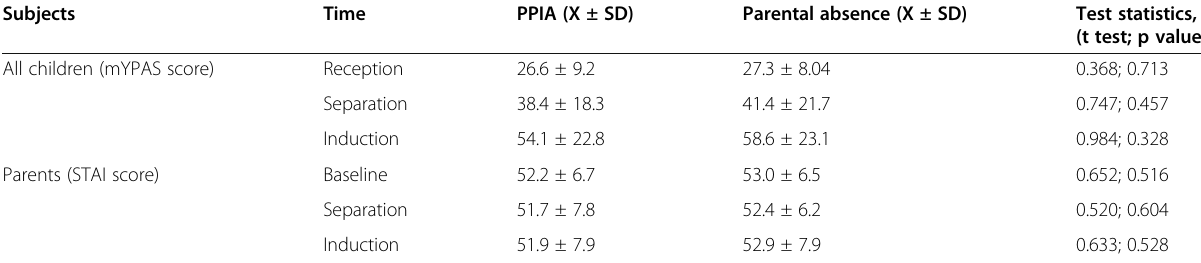
Table 3 Comparison of mean anxiety scores of patients and parents between PPIA and parental absence Subjects